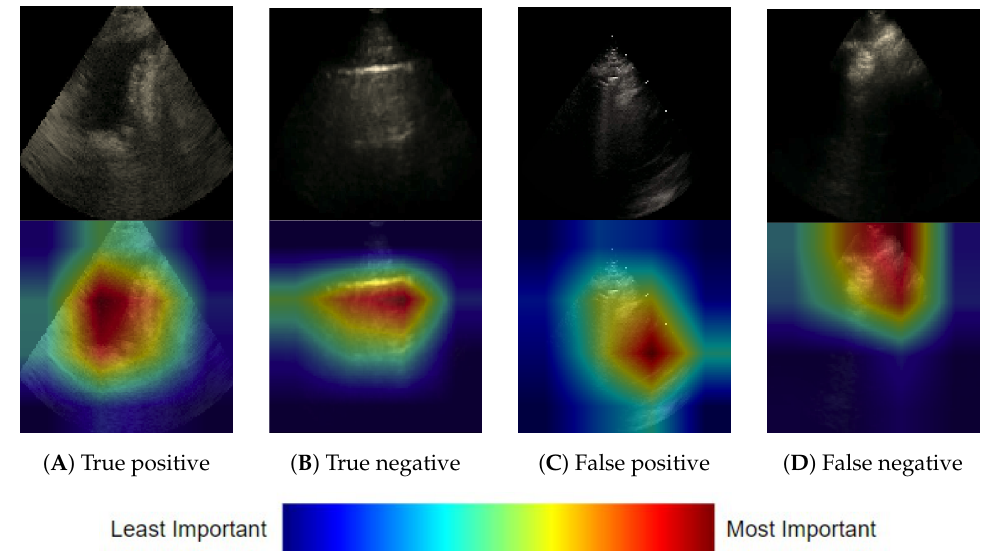
Figure 6. Selected Grad-CAM++ explanations for the neural network model view predictions for single LUS frames. Red regions were the most important to the prediction. The true positive ( A ) is confirmed by the heat map highlighting a pleural effusion which is only seen in the pleural view, and the true negative ( B ) highlights an A line, or reverberation, artifact seen in parenchymals views. The false positive ( C ) highlights the heart likely mistaken as an abdominal organ found in pleural views, and the false negative ( D ) highlights transient parenchymal tissue that comes into frame during